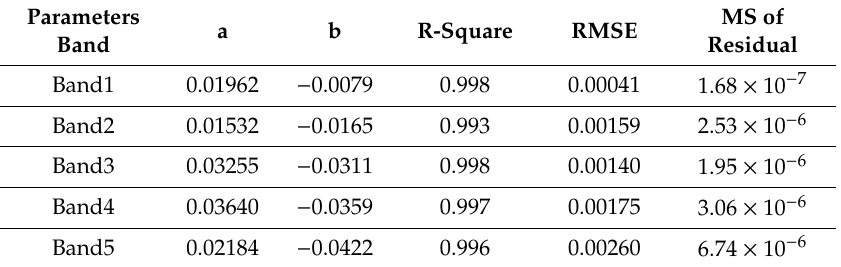
( b ) Figure 17. Verification experiments: ( a ) layout of observation targets; ( b ) schematic of the experimental setup.